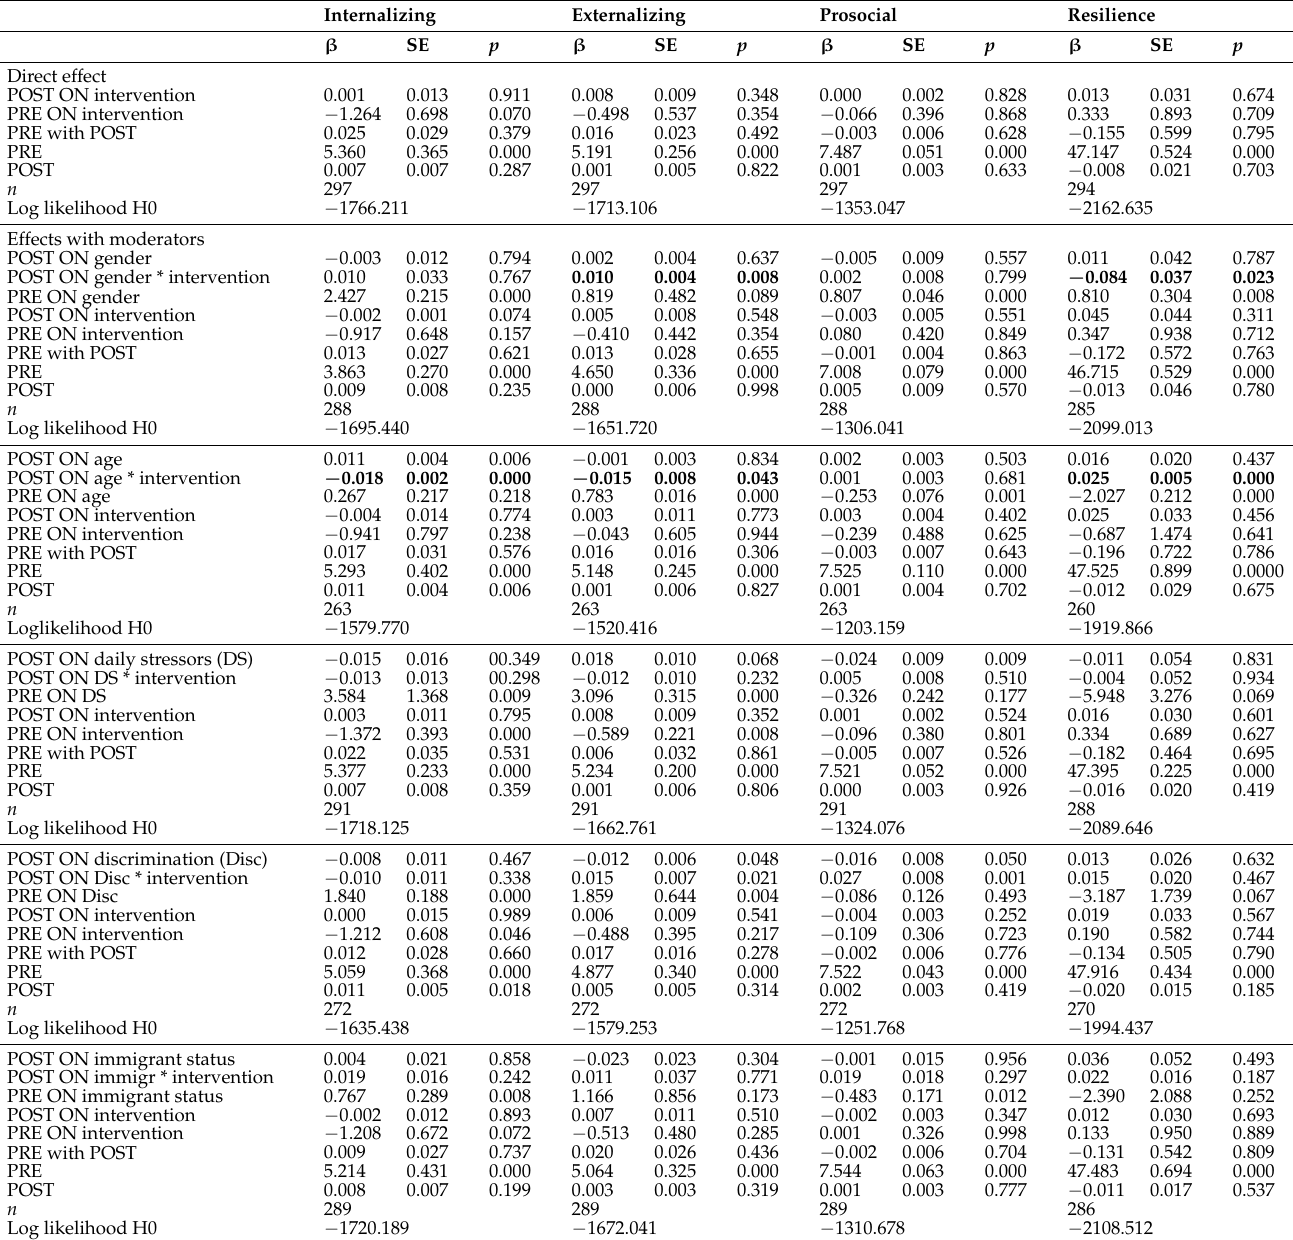
Table 6. Latent growth models for Finnish-born and immigrant students regarding PIER